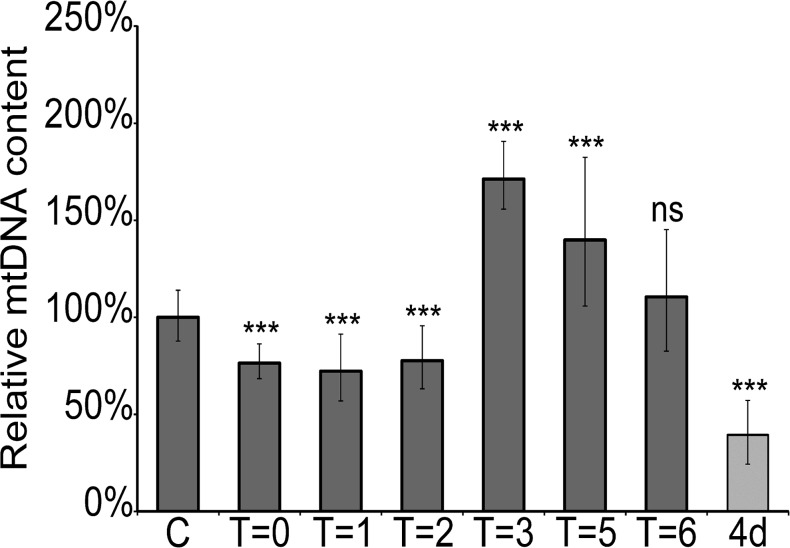
Recovery of mtDNA after cessation of exposure.Worms are exposed to FLT (200 μM) from D1 of adulthood onwards for 72hrs after which they are transferred to plates without FLT. This results in a recovery of mtDNA. Error bars show the 95% C.I. (df = 16). C = untreated worms, T = #hr after transfer, 4d = 4days of continuous exposure. Significance was determined using a two-tailed student’s T test assuming unequal variances. ***P-value <0.001 compared to unexposed animals. ns: not significant compared to unexposed animals.